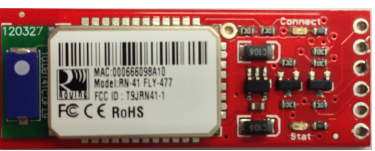
Figure 11. Bluetooth Mate Gold.